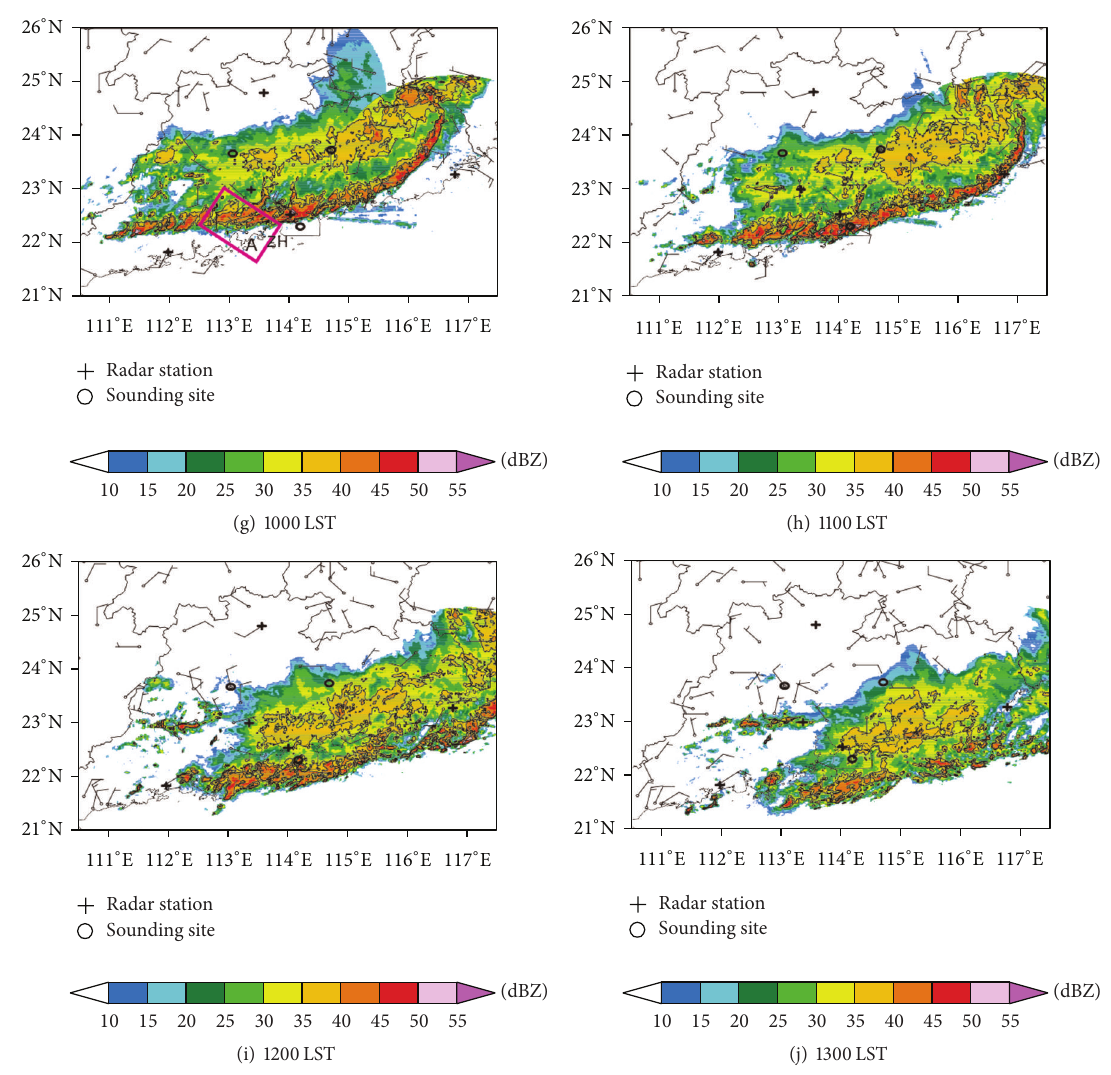
Figure 8: Radar reflectivity mosaic data at 2.5 km altitude and the surface wind field between 0400 and 1300 LST 24 April 2007. Rectangle A in (g) shows the dual-Doppler wind retrieval domain. The contours are 35 dBZ, 40 dBZ, and 50